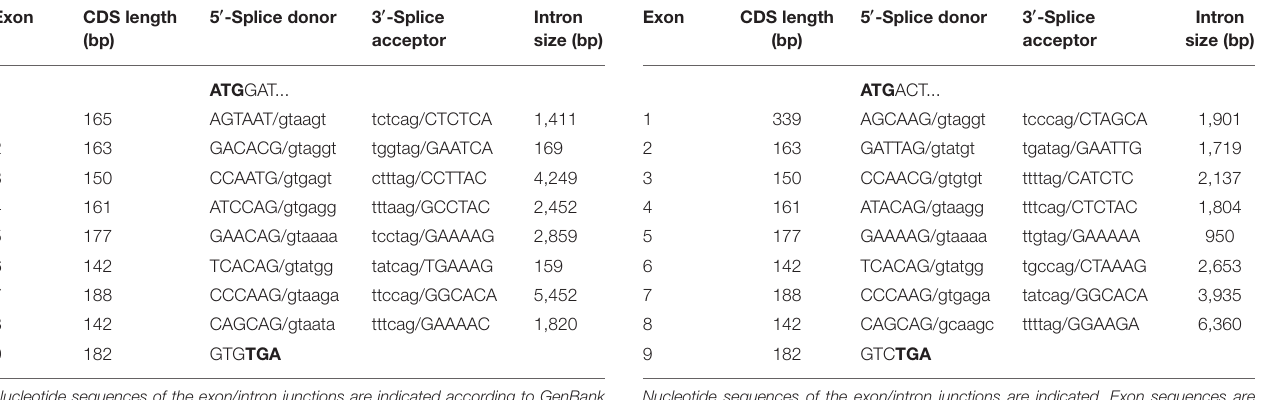
FIGURE 1 | Both gene clusters are bordered by the HELLS and PDLIM1 genes. The canine CYP2C41 gene was schematically introduced based on experimental data from the present study, which demonstrated localization downstream of the HELLS gene. Sites of recombination (SOR 1 and SOR 2) are indicated. (B) Oligonucleotide primers specific for each proposed exon of the CYP2C41 gene were used for PCR amplification from DNAs from different subjects. Data are representatively shown for a CYP2C41 positive subject (dog 1) and a CYP2C41 negative subject (dog 2). As a control, all CYP2C21 gene coding exons were also amplified with gene-specific primers. All amplicons were separated by agarose gel electrophoresis. M, molecular weight DNA marker (100-400 bp). The underlined exons were also examined in subsequent analyses. (C) Schematic presentation of the CYP2C41 genotyping strategy. Subjects were screened for the presence of the CYP2C41 gene with the oligonucleotide primers EX7-F/R, both located on exon 7 of the CYP2C41 gene. The primers EX3-F/R were used as controls to amplify exon 3 from the CYP2C21 gene. Amplification with the primers SOR-F3/R4 or SOR-F4/R3 only produced positive results in the presence of the CYP2C41 gene, whereas amplicons with the primers SOR-F3/R3 indicated the CYP2C41 gene deletion. Of note, DNA sequence patterns were identical at break points 1 and 2 of all CYP2C41 positive subjects (indicated by red boxes). In addition, the exact positions of the respective gene segments are indicated.